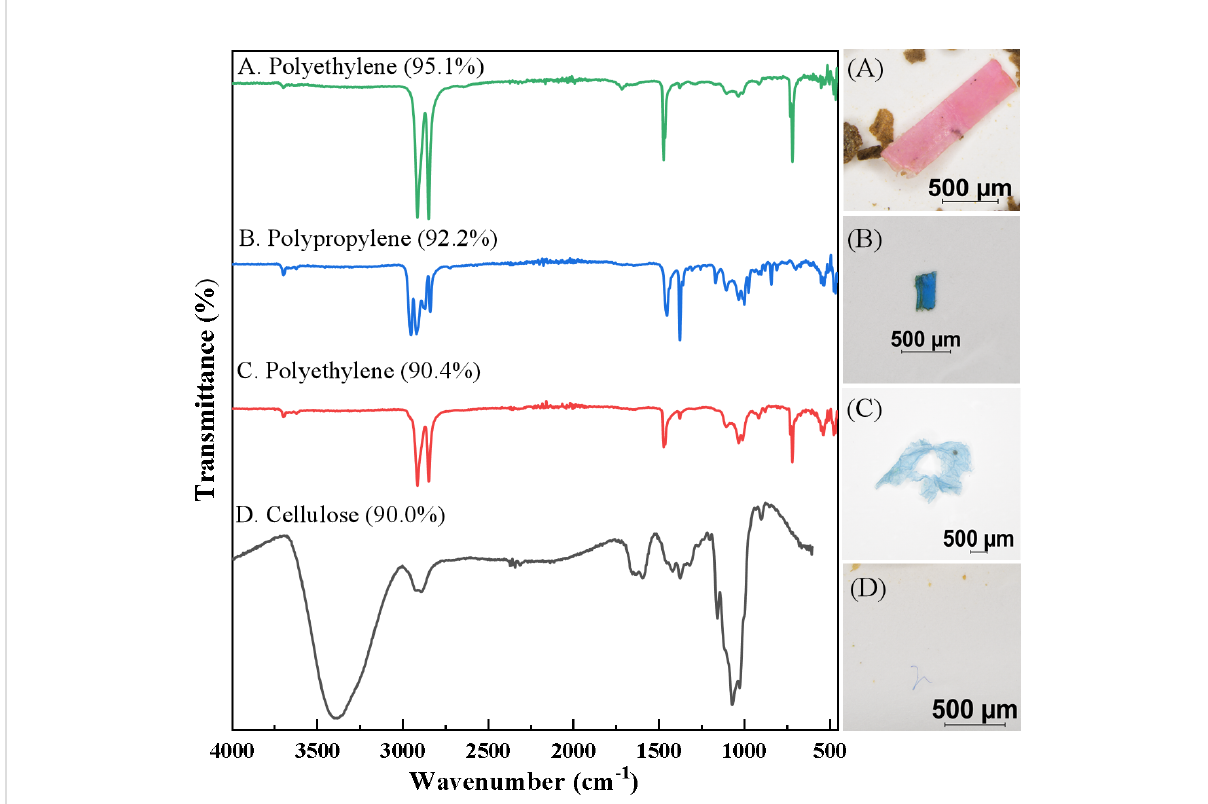
FIGURE 4 Typical microplastics (MPs) trapped in surface sediments of mangrove forests. (A) red fragment, (B) blue fragment, (C) blue fi lm, and (D) blue fi